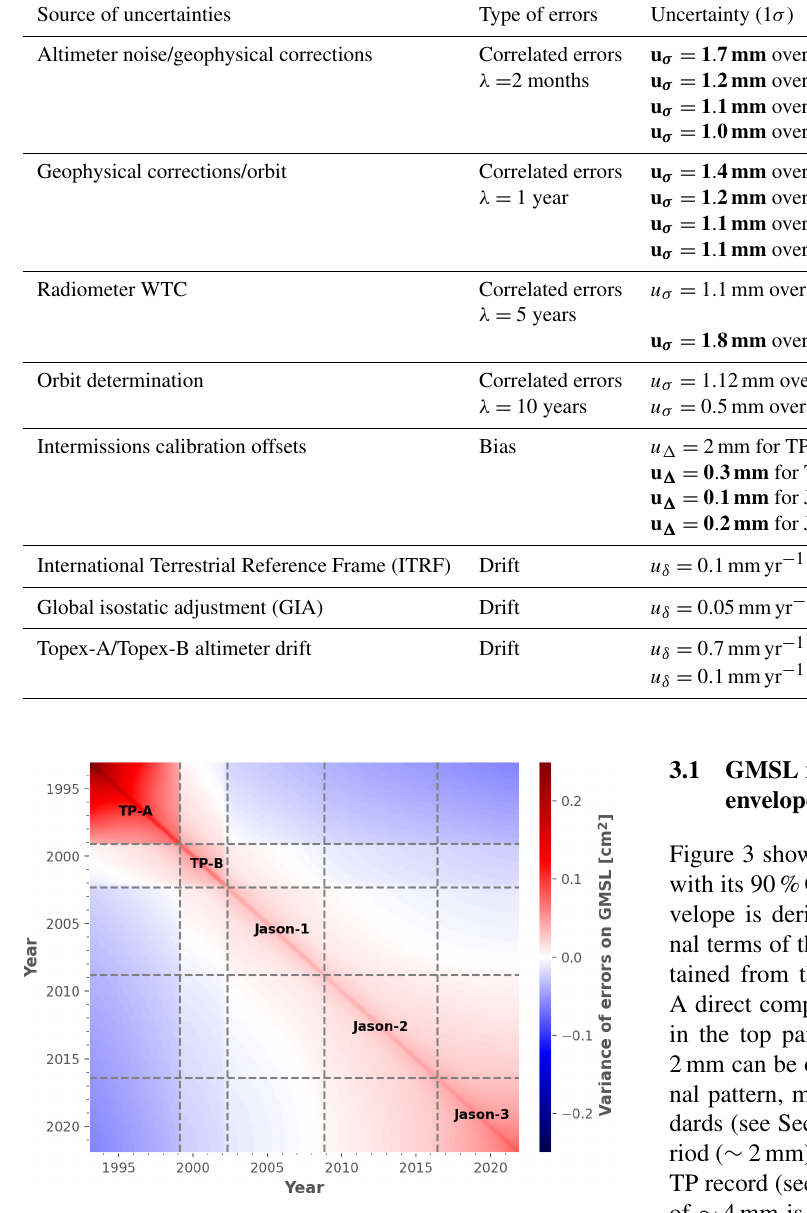
Figure 2. Error variance–covariance matrix of the L2P21 GMSL obtained from the revised uncertainty budget presented in Table